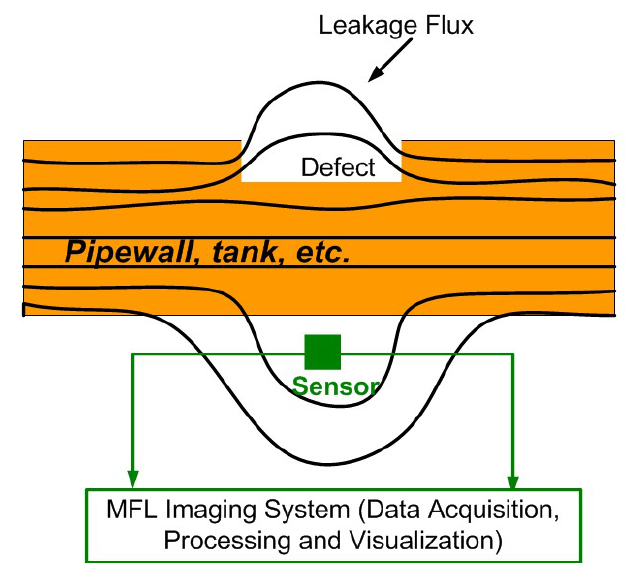
Figure 2. MFL inspection and imaging of gas pipelines.